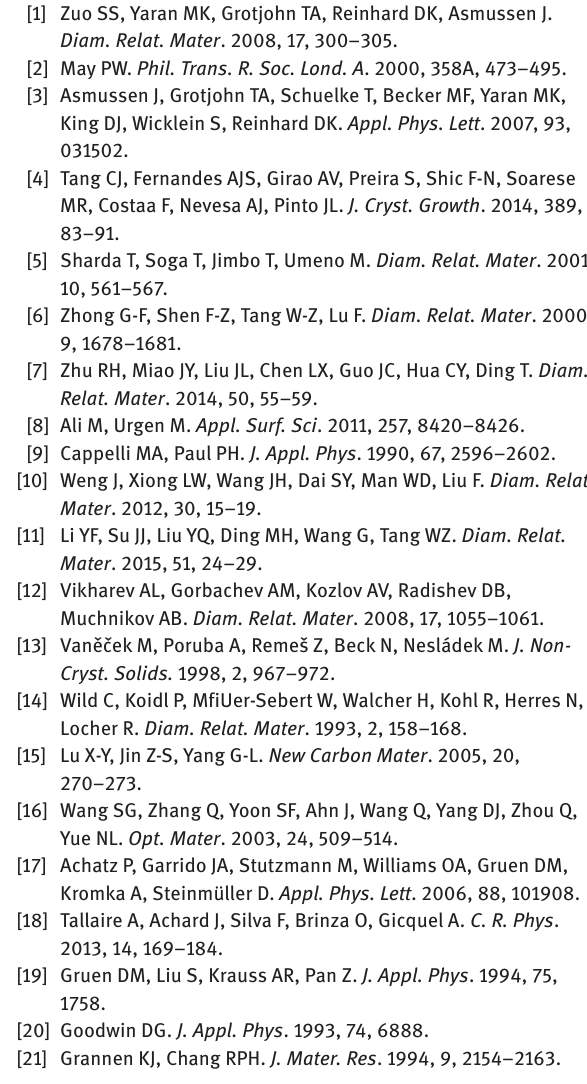
-2, Ar-0; (B) O -2, 2 2